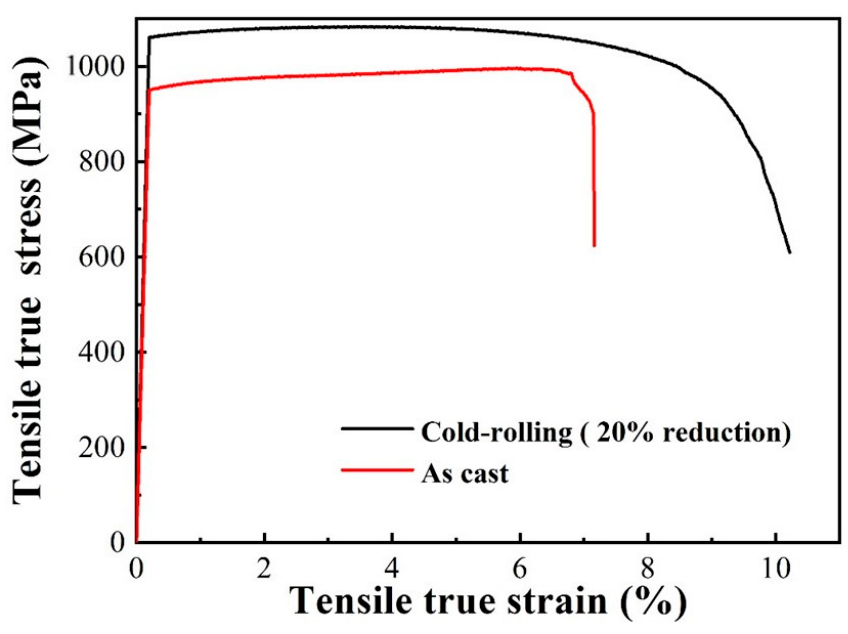
Figure 8. Tensile true stress–strain curves for the (TiZr) 0.8 (NbTaV) 0.2 RHEA at room temperature.